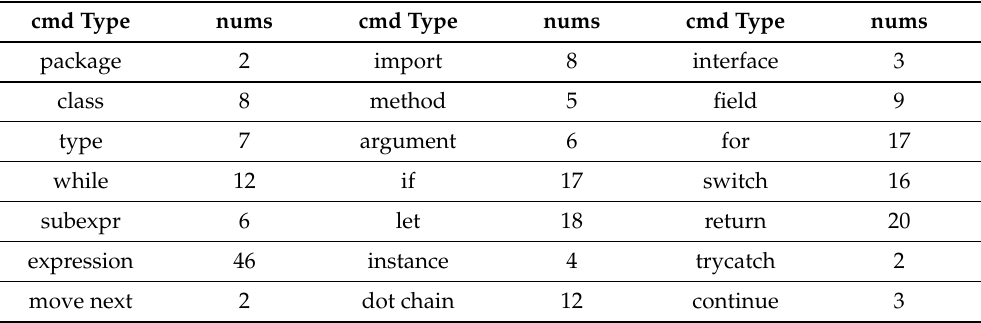
Table 2. A summary of test